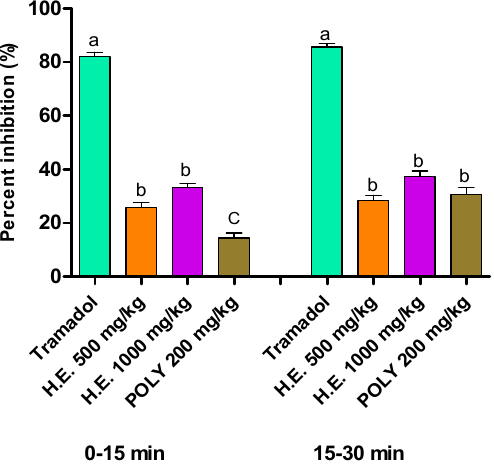
Figure 4. Percent of inhibition of formalin-induced pain in mice following the application of hydro- ethanolic (H.E.) and polyphenolic (Ploy) extracts of P. sativum Hoffm. and Tramadol (positive control). Inhibition rates were determined compared to the non-treated animals. The different letters in superscript (a, b, c) indicate the significant difference between treatments at p < 0.05.